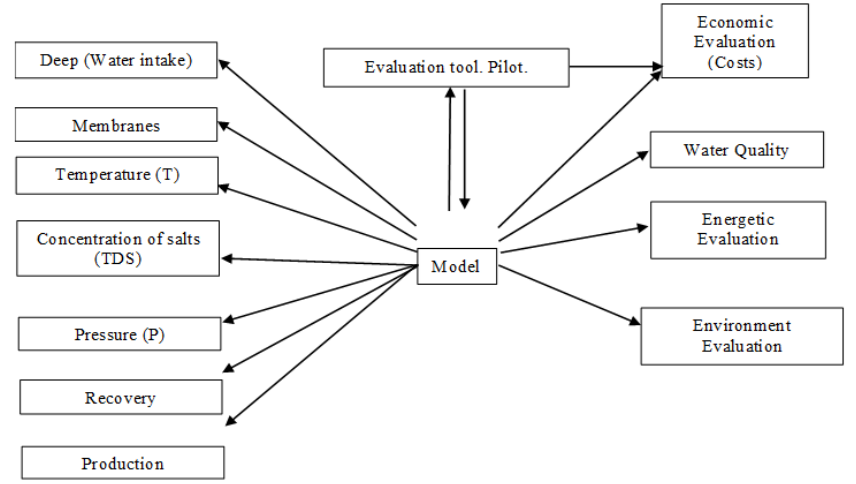
Figure 1. Block diagram of the integral model.